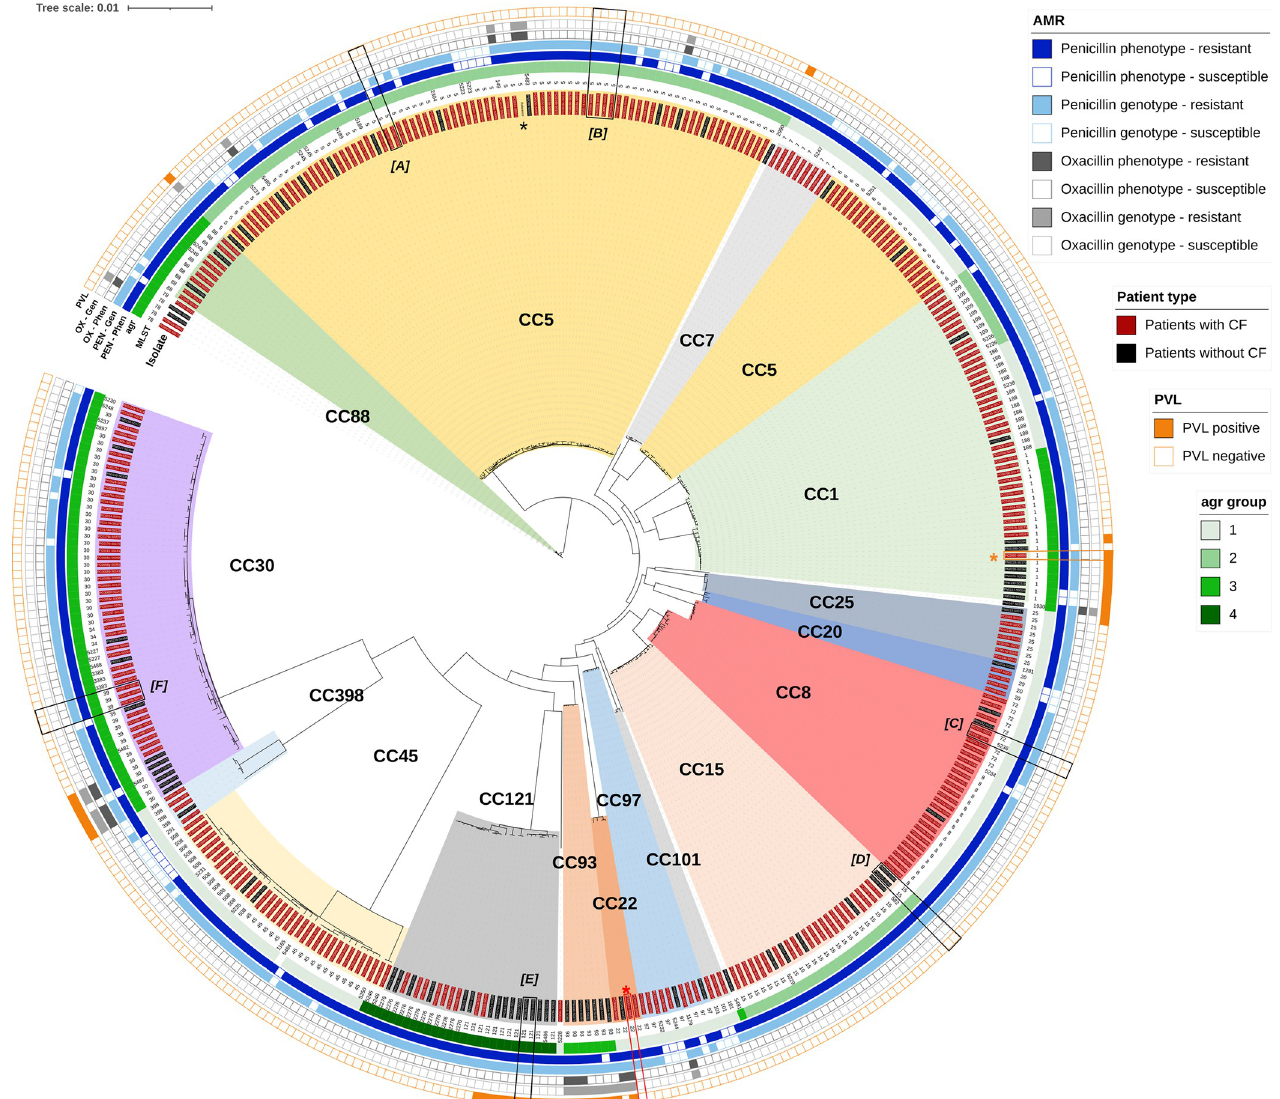
Fig 1. Circular phylogram of S . aureus isolates from patients with and without CF.